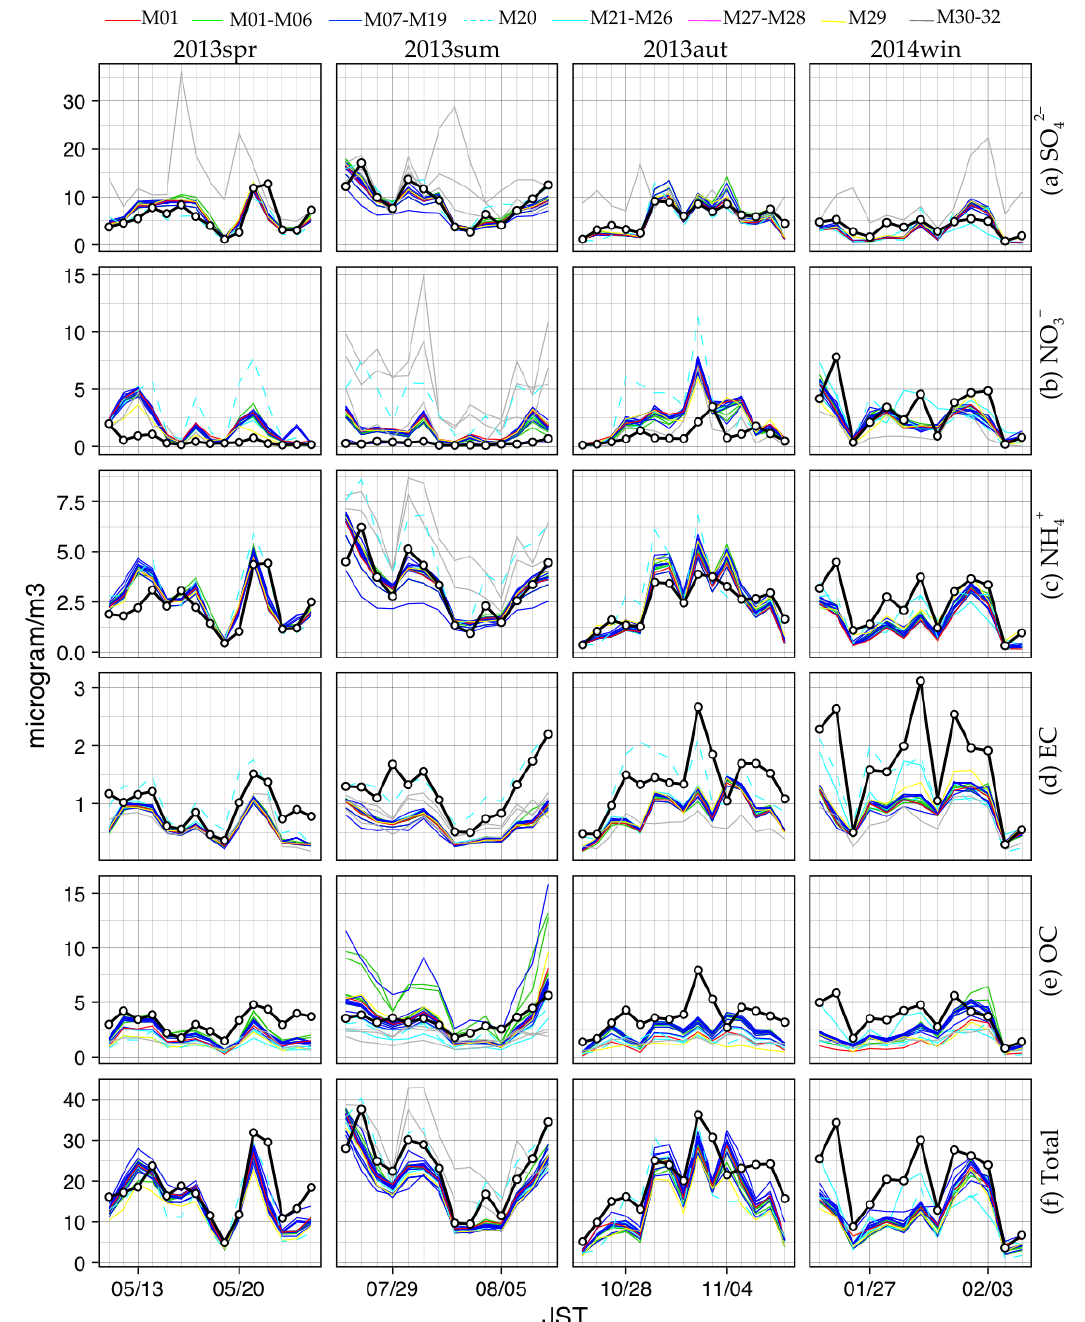
Figure 8. Spatially averaged concentrations of PM 2.5 : ( a ) SO 42 − , ( b ) NO 3 − , ( c ) NH 4 + , ( d ) EC, ( e ) OC, and ( f ) total PM 2.5 mass over the four seasons. These results are based on daily concentrations observed and simulated for AAPMSs in d03. The thick solid lines with open circles present observations, and the colored lines present model results.